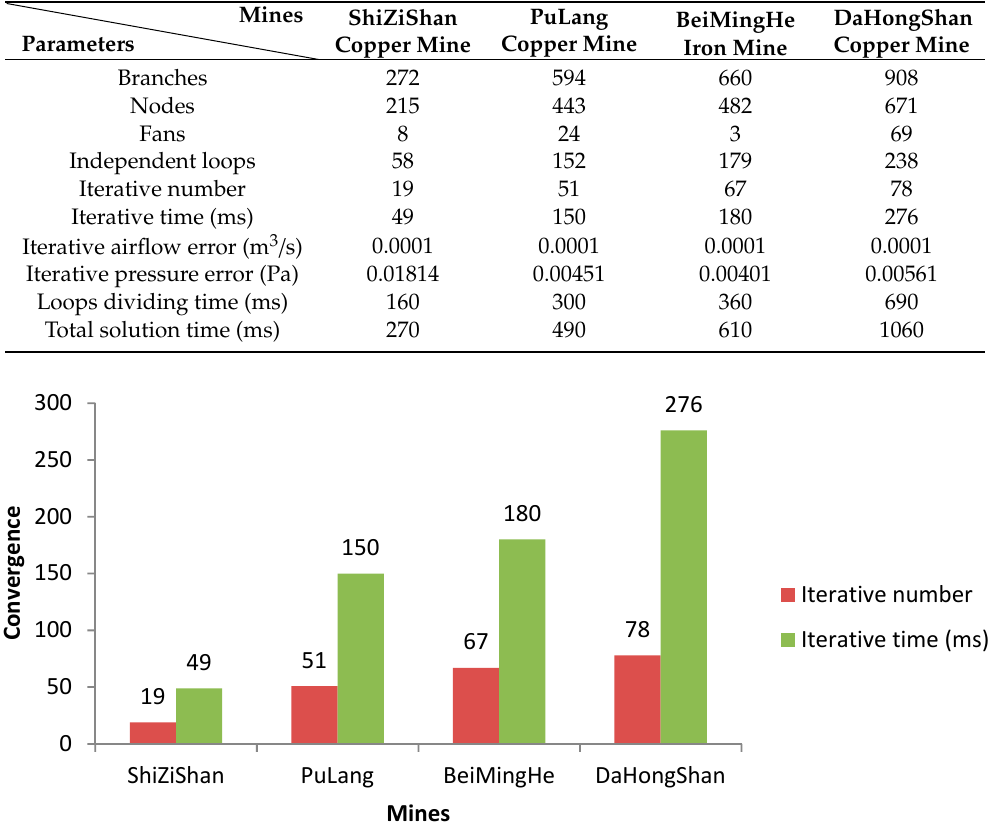
Figure 9. Solution convergence graph of four actual mines.